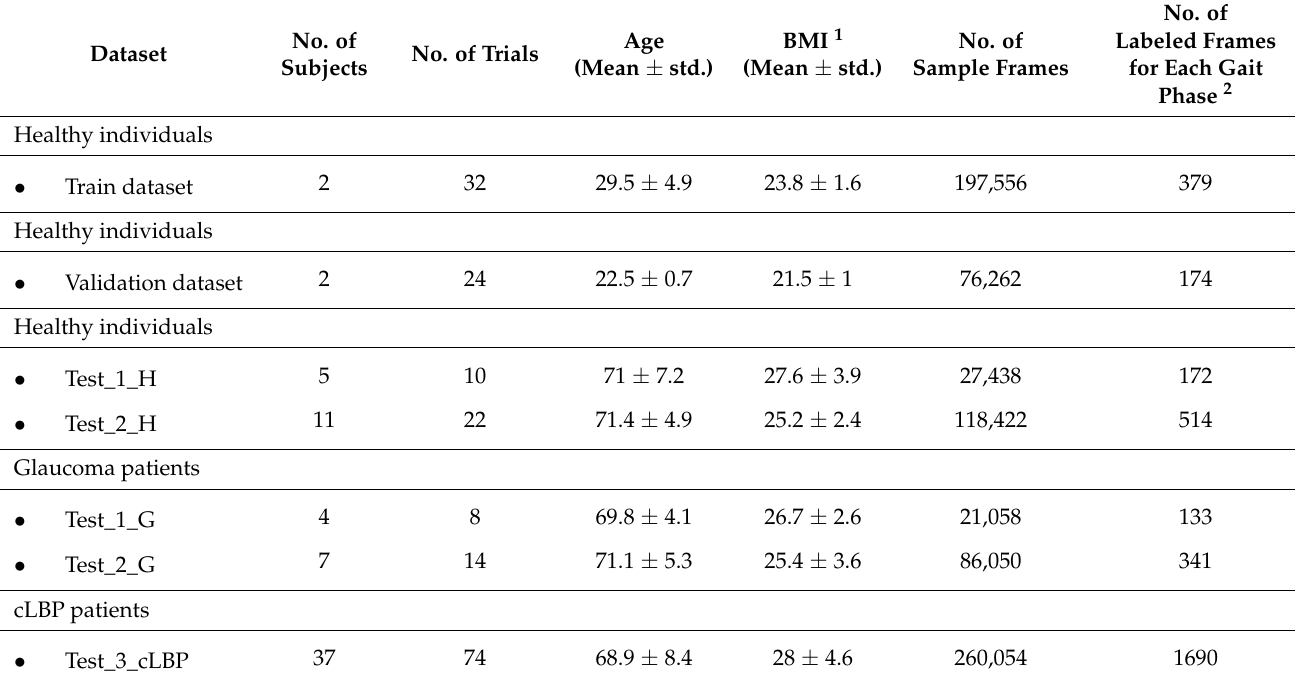
Table 1. An overview of the datasets and some characteristics of the